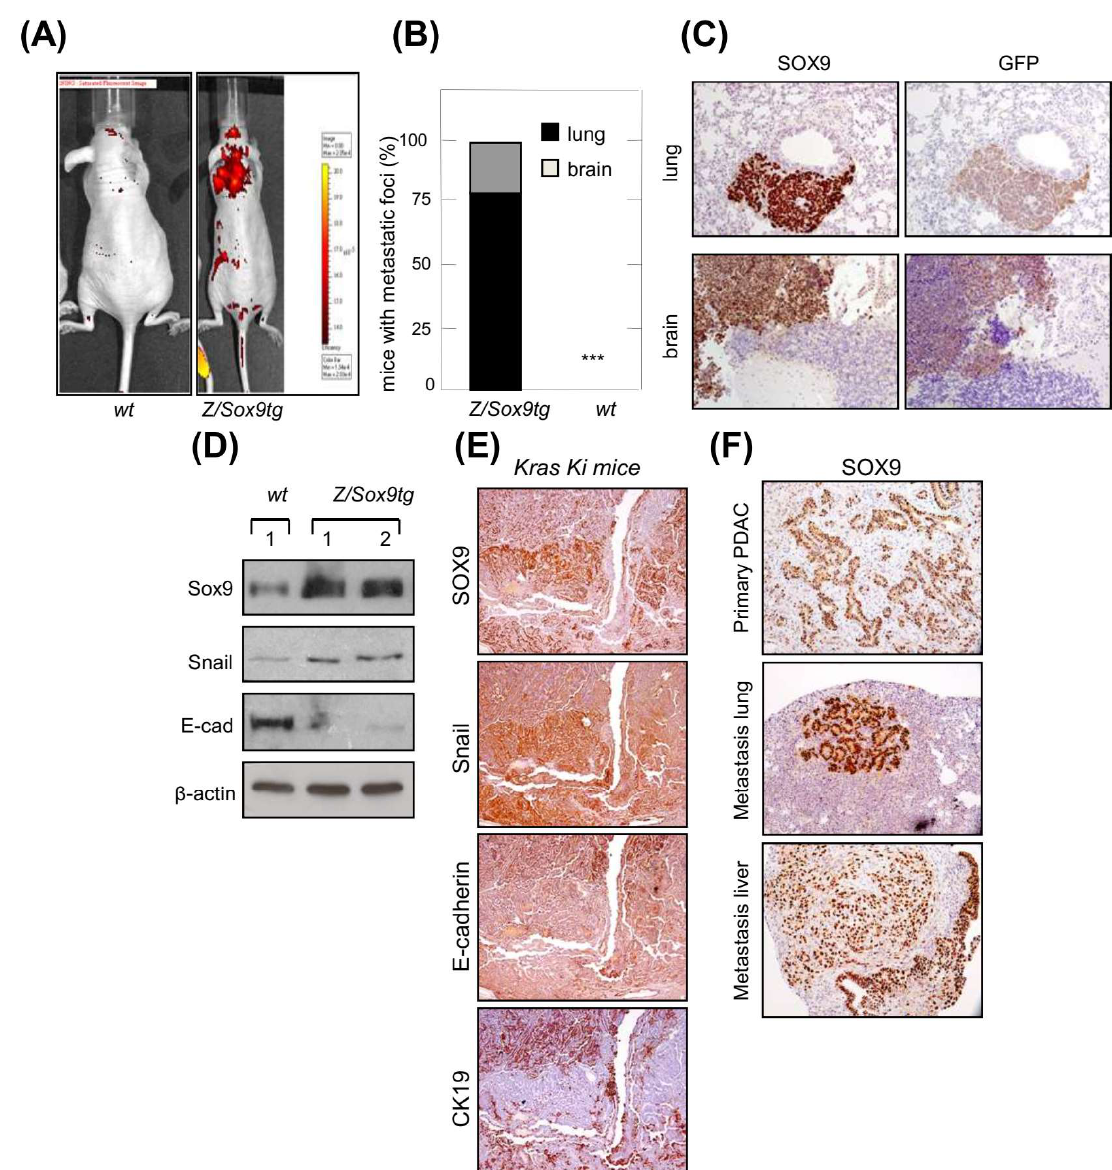
Figure 1. SOX9 overexpression promotes EMT and confers metastatic potential in K-Ras transformed cells. ( A ) Representative picture of metastatic tumors derived from intravenously injected E1a/Ras transformed MEFs with ectopic Sox9 expression ( Z/Sox9tg) (right, n = 5) or wild type MEFs ( wt ) (left, n = 5) in nude mice. Images obtained with an IVIS-200 in vivo imaging system. ( B ) Quantification of the percentage of nude mice that developed metastatic tumors derived from Z/Sox9tg ( n = 5) and wt MEFs. ( C ) Sox9 and GFP expression analyzed by immunohistochemistry in lung and brain metastasis established by E1a/Ras transformed Z/Sox9tg MEFs. ( D ) Analysis by Western blot of Sox9, Snail and E-Cadherin levels in neoplastically transformed wt and Z/Sox9tg MEFs. ( E ) Serial sections of K-Ras G12V- induced lung adenocarcinomas stained with Sox9, Snail and the epithelial markers, E-cadherin and CK19. Representative image from at least three different mice. ( F ) Representative images of Sox9 expression analyzed by immunohistochemistry in sections from K-Ras/p53 − / − induced primary pancreatic tumors and metastatic tumors in lung and liver ( n = 5). *** indicates statistical significance with p <